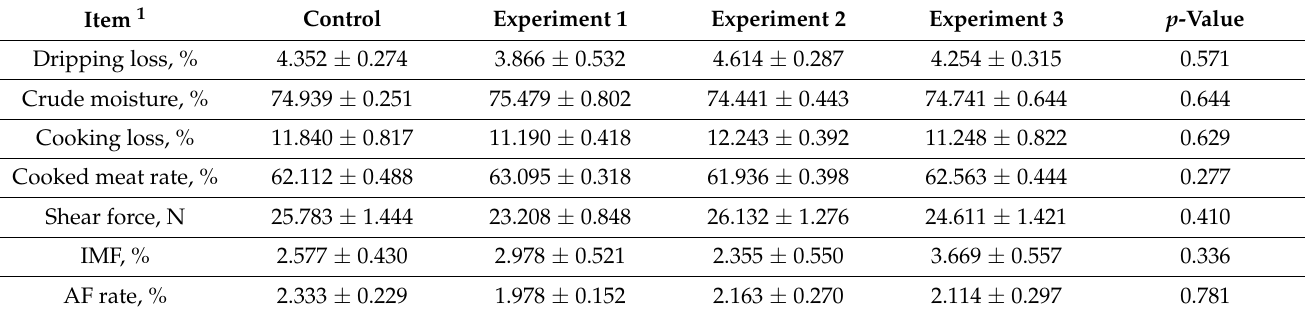
Table 3. Meat quality of broiler.